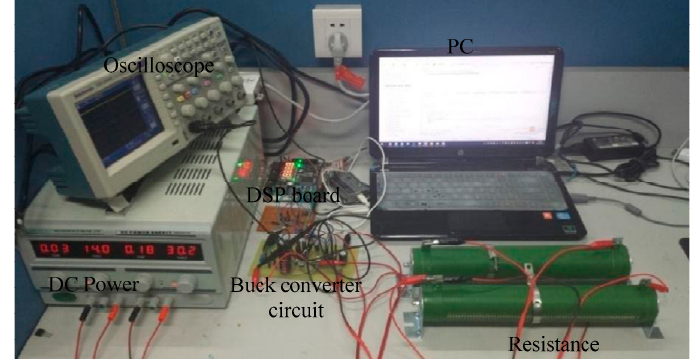
Figure 10. Experimental setup.